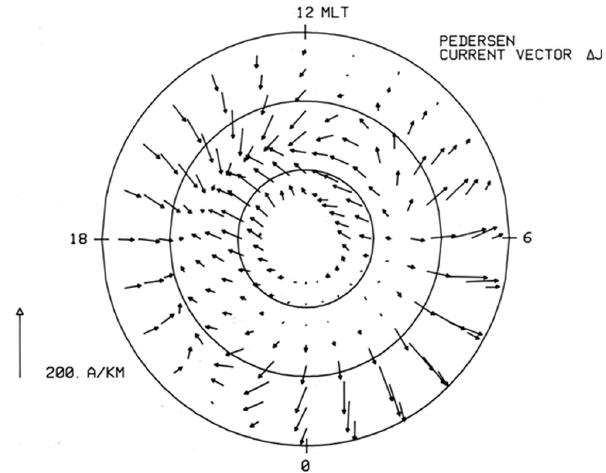
Fig. 11. The distribution of the Pedersen current (Kamide and Aka- sofu,